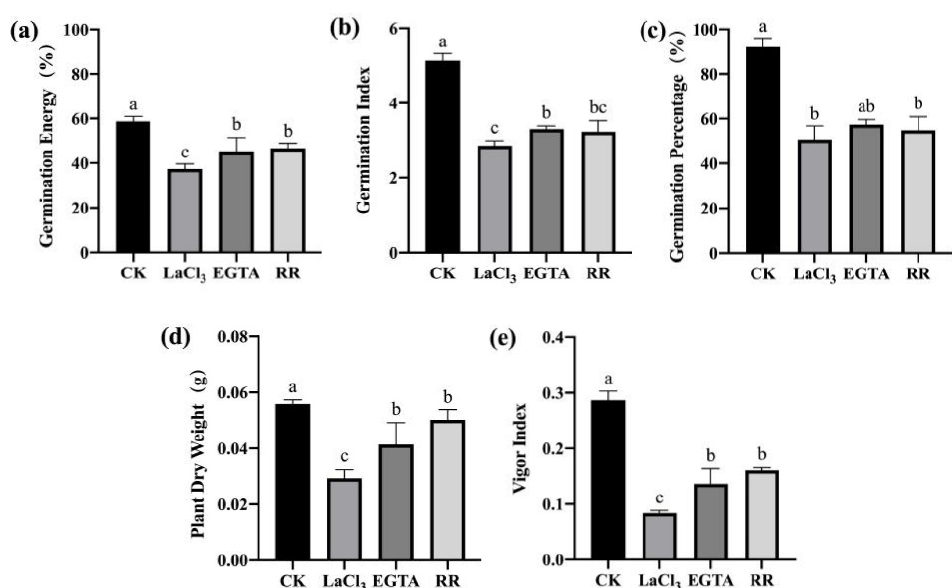
Figure 7. Ca 2+ chelating agent/channel inhibitor treatments inhibited seed germination and seedling growth of high-vigor maize seeds. ( a ) germination energy (%), ( b ) germination index, ( c ) germination percentage (%), ( d ) dry weight of single plant (g), ( e ) vigor index. EGTA, ethylene glycol-bis(beta- aminoethyl ether)- N -tetraacetic acid; RR, Ruthenium Red; CK, control. Different letters indicate significant differences among different lines (Tukey’s test).